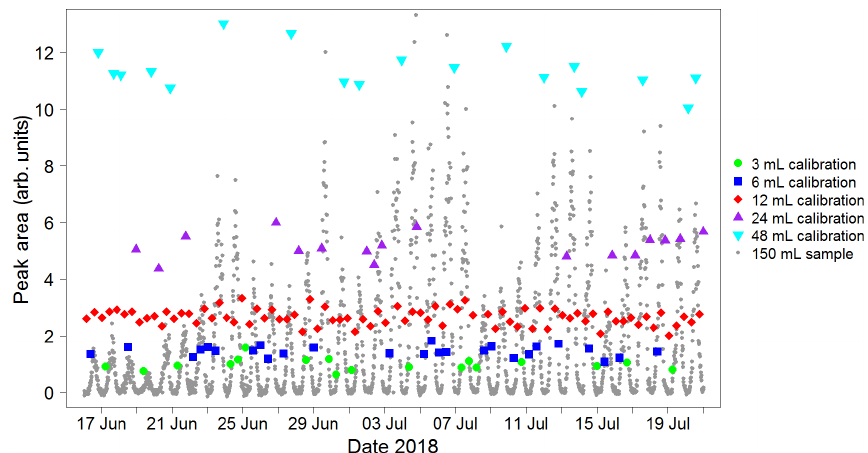
Figure 6. Typical sequence of isoprene peak areas for runs with varying calibration volumes. These, once split into weekly segments, are used to produce a calibration curve (see Fig. 7). The calibration runs with the standard user-specified sampled volume (red data points) are used to calculate the instrument precision on a weekly basis (see Sect. 4.2). Peak areas from sample runs (grey data points) are also shown to illustrate how the calibration peak areas span the entire range of sample values, minimising the need for extrapolation. This plot was produced using data from the Wytham Woods field campaign (see Sect. 5.2).